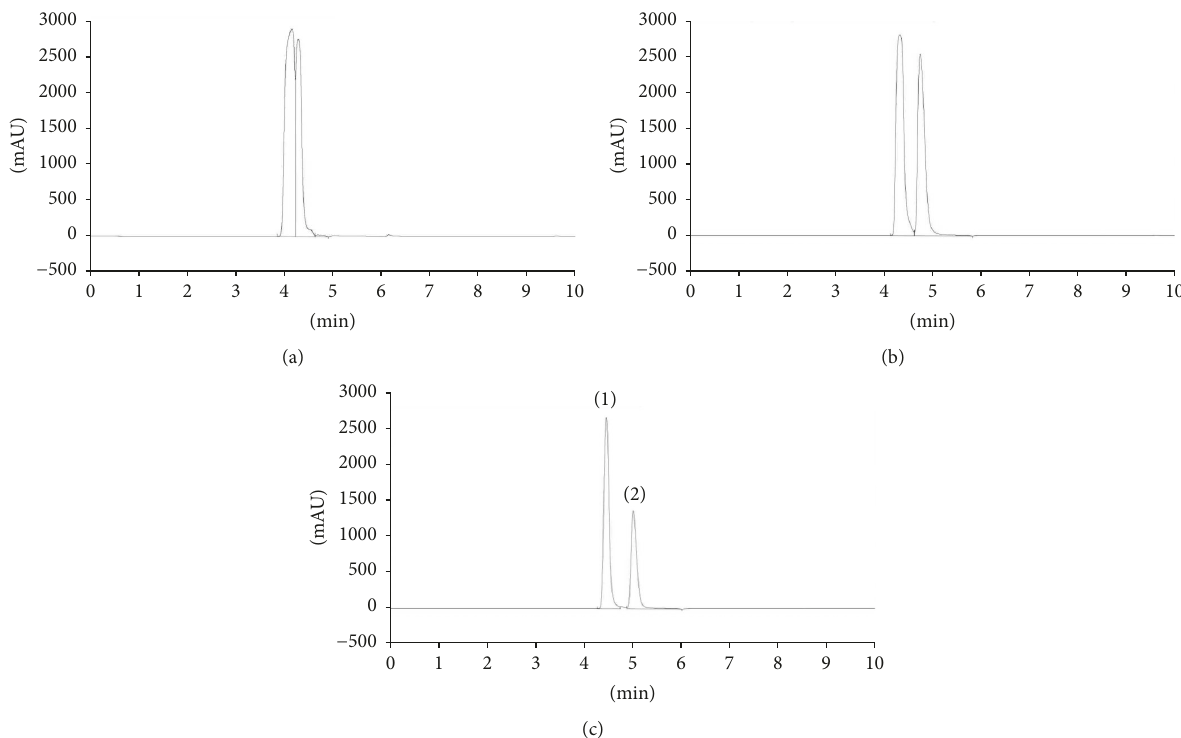
Figure 3: Comparative chromatograms showing isocratic RP-HPLC separation of mixed standard, L-citrulline, and L-arginine in different mobile phases: (a) 0.7% H 3 P0 4 : ACN (90 :10); L-citrulline and L-arginine were unretained and coeluted at 𝑘 value close to zero; (b) 0.7% H 3 P0 4 ; L-citrulline and L-arginine were slightly retained and partially separated; (c) 0.1% H 3 P0 4 ; L-citrulline and L-arginine were efficiently separated with reproducible peaks. The peaks marked represent (1) L-arginine and (2) L-citrulline.